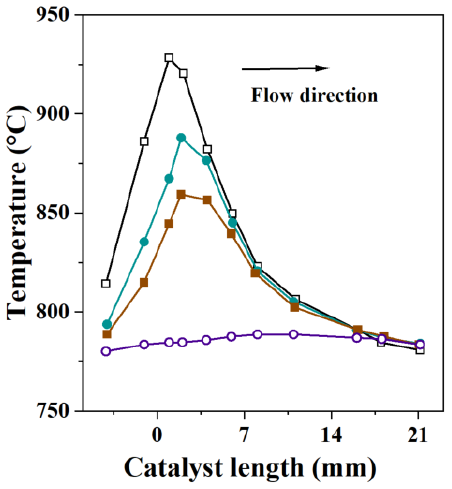
Figure 20. PBR axial temperature profile as a function of catalytic bed reactor (1.0 mL) length